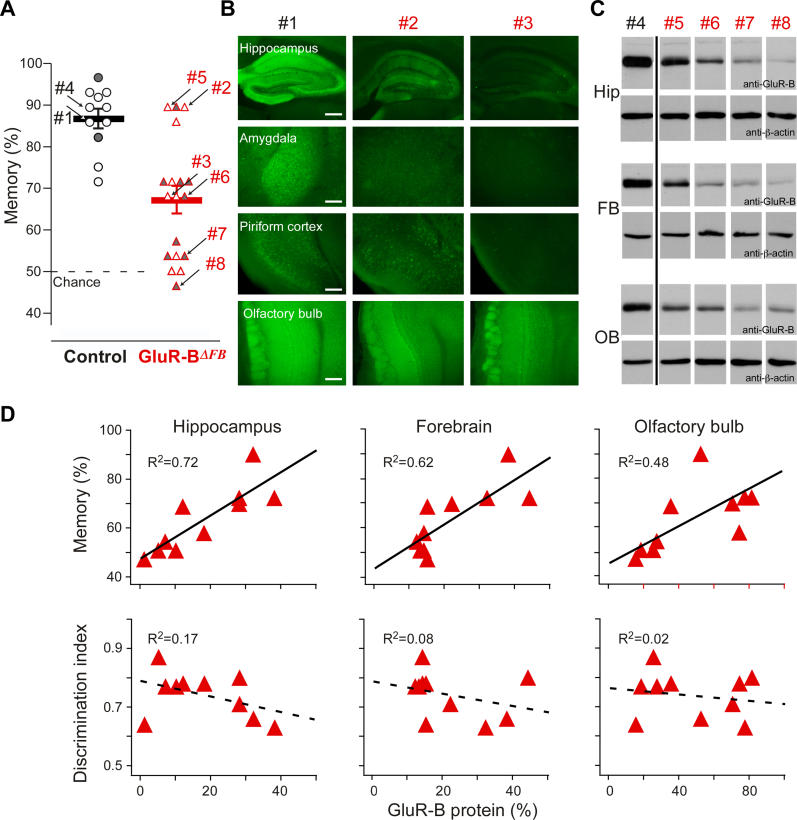
Olfactory Memory but not Odor Learning/Discrimination Is Correlated with Residual GluR-B Levels in Hippocampus and Forebrain of GluR-BΔFB Mice(A) The olfactory memory performance for 18 GluR-BΔFB (red) and 11 littermate control (black) mice is given as mean (thick lines ± SEM) and as individual performance in open circles and triangles. Arrows with numbers (#) indicate those mice used in experiments (B–C). Data were combined from Figure 2 (open symbols) and an additional experiment with nine GluR-BΔFB and two littermate controls (shaded symbols).(B and C) Residual GluR-B levels as detected by anti-GluR-B immunofluorescence in hippocampus, amygdala, piriform cortex, and olfactory bulb of one control (#1) and two GluR-BΔFB (#2 and #3) coronal mouse brain sections (B) and by immunoblot analysis from hippocampal (Hip), cortical forebrain (FB), and olfactory bulb (OB) protein extracts of control (#4) and GluR-BΔFB mice (#5, #6, #7, and #8) probed with antibodies detecting GluR-B and β-actin as an internal loading control (C). Scale bars: 200 μm (first panel), 100 μm (other panels).(D) From ten GluR-BΔFB mice, the individual odor learning/discrimination and olfactory memory performance was determined together with the relative GluR-B levels in immunoblots of hippocampal, forebrain, and olfactory bulb protein extracts. Memory performance (top panels) and discrimination capability (bottom panels; discrimination index is measured for the last 100 trials of the mixture discrimination task as indicated by the arrow in Figure 2C) were plotted against GluR-B levels. Memory was tightly correlated to GluR-B protein level in hippocampus (R2 = 0.72; p < 0.003) and cortical forebrain (R2 = 0.62; p < 0.006) and only weakly in the olfactory bulb (R2 = 0.48; p = 0.03). No measure of learning/discrimination (discrimination index for last 100 mixture trials [D], slopes of trend lines, average discrimination index, average sampling pattern differences, correct performance, etc. [not shown]) displayed any correlation (R2 < 0.3).